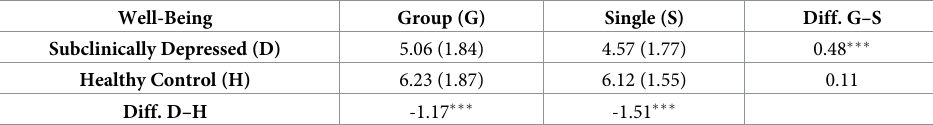
Table 9. Well-being before feedback by treatment. Well-Being